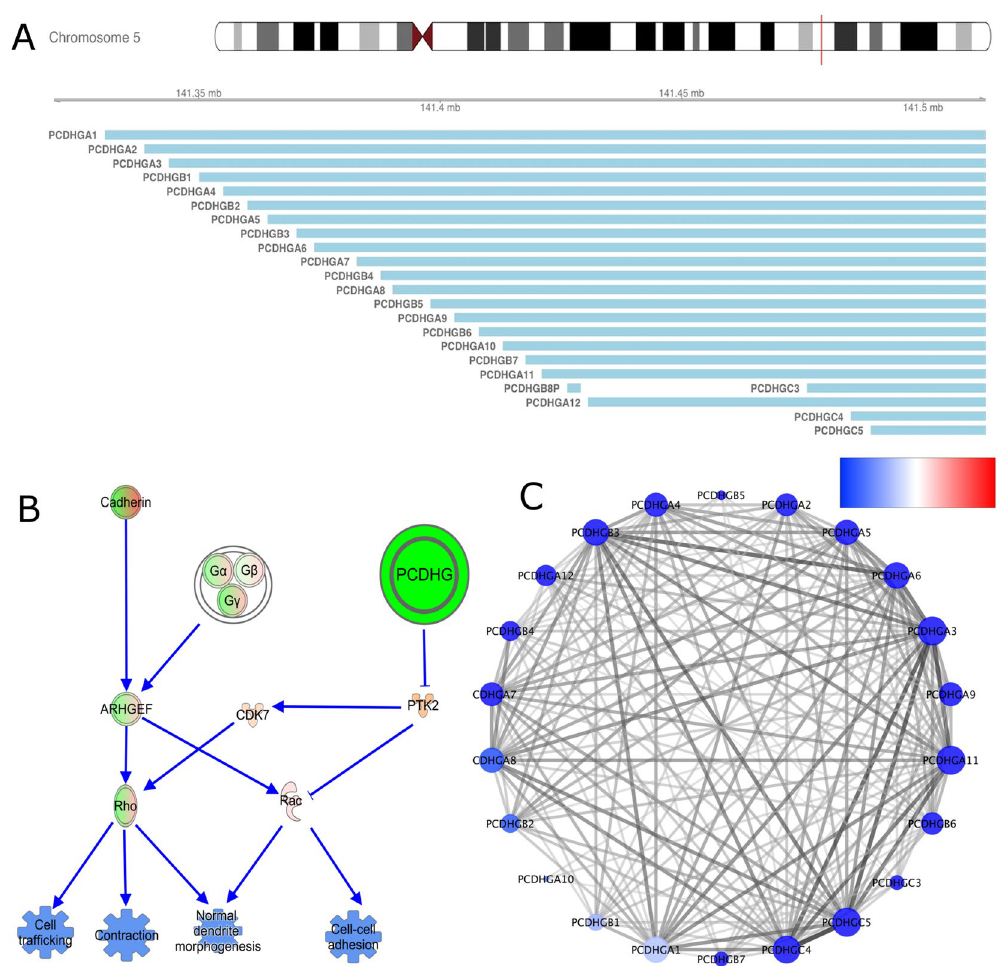
Figure 4. γ -Protocadherin complex (PCDHG) and its putative role in breast cancer. ( A ) Chromosomal localization of the 22 γ -protocadherins. ( B ) Signalling pathway involving G-proteins, protocadherins and their targets in the cell trafficking, contraction and cell adhesion processes. Molecule expression values are presented in colors and the expected activation state given by those expression values: under/overexpressed genes in green/red-orange respectively. Blue events represent downregulated processes. Red-green vertex represent molecule complexes that include overexpressed and underexpressed molecules together. ( C ) The PCDHG cluster obtained in the cancer network. Notice that all genes are underexpressed (blue color). Transparency and color edges intensity are according to the mutual information values